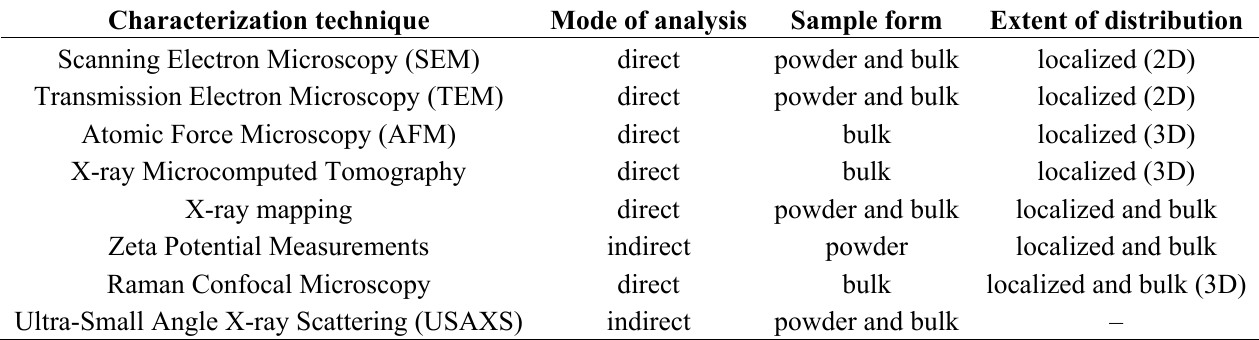
Table 1. Qualitative characterization